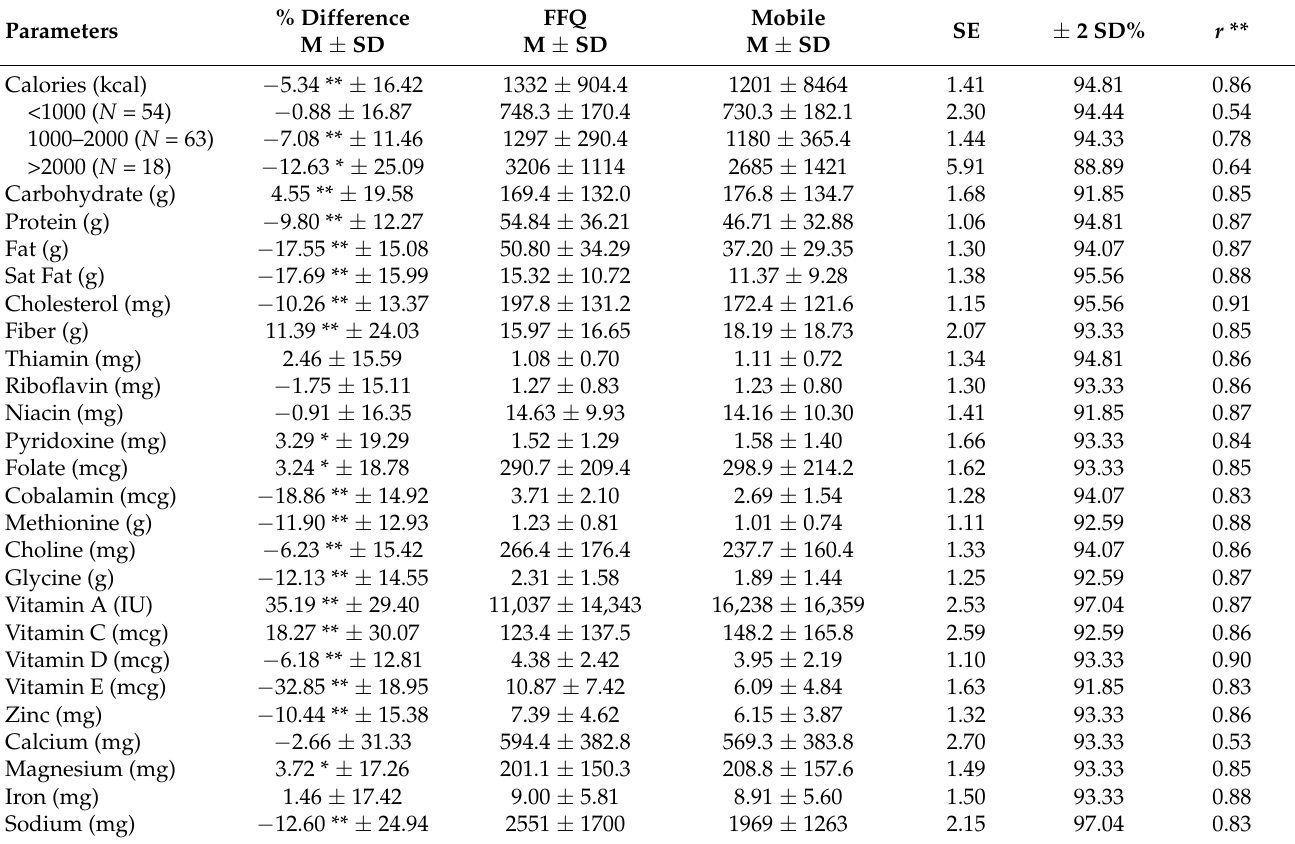
Table 1. Agreement and bias for the mobile application against Food Frequency Questionnaire ( N = 135).